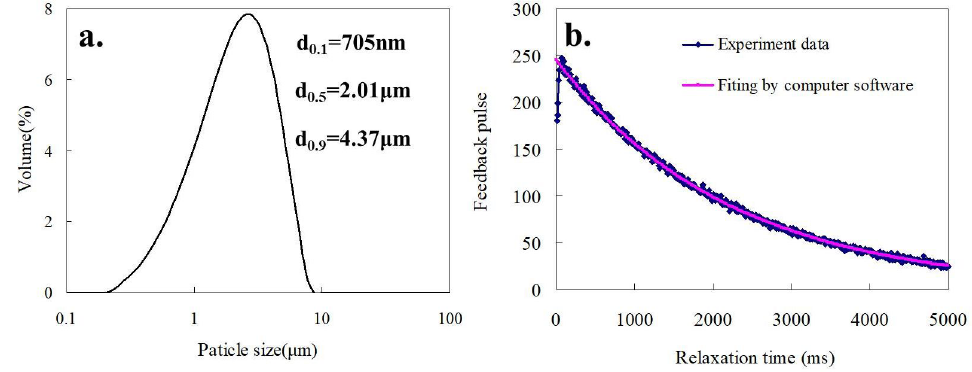
Figure 4. Particle size distribution and liquid specific surface area results of ANS Catalyst.